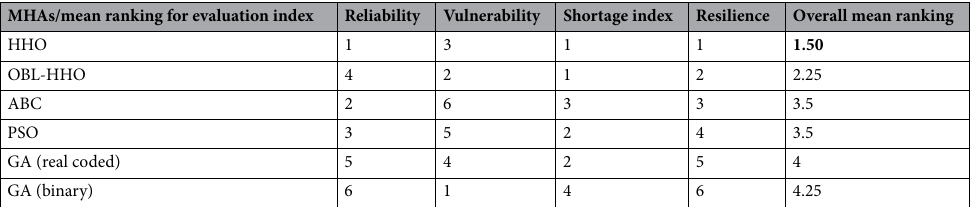
Table 6. Ranking system in evaluation of risk and reliability analysis. Significant values are in